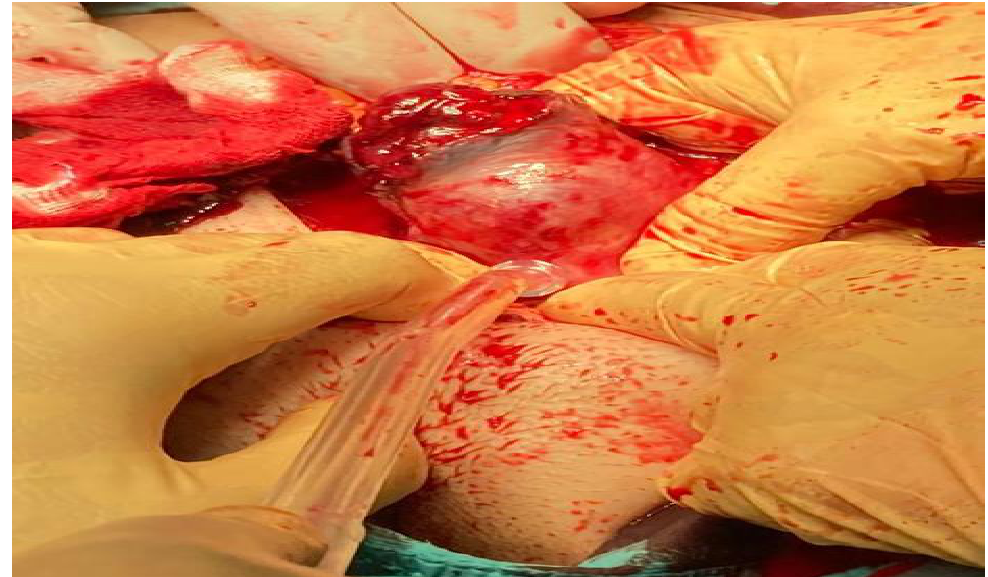
Figure 8. Laparotomic view of cornuectomy after interstitial pregnancy uterine rupture.